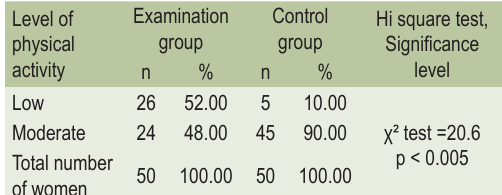
FIGURE 3. Level of physical activity of women without estro- gen de fi ciency (moderate physical